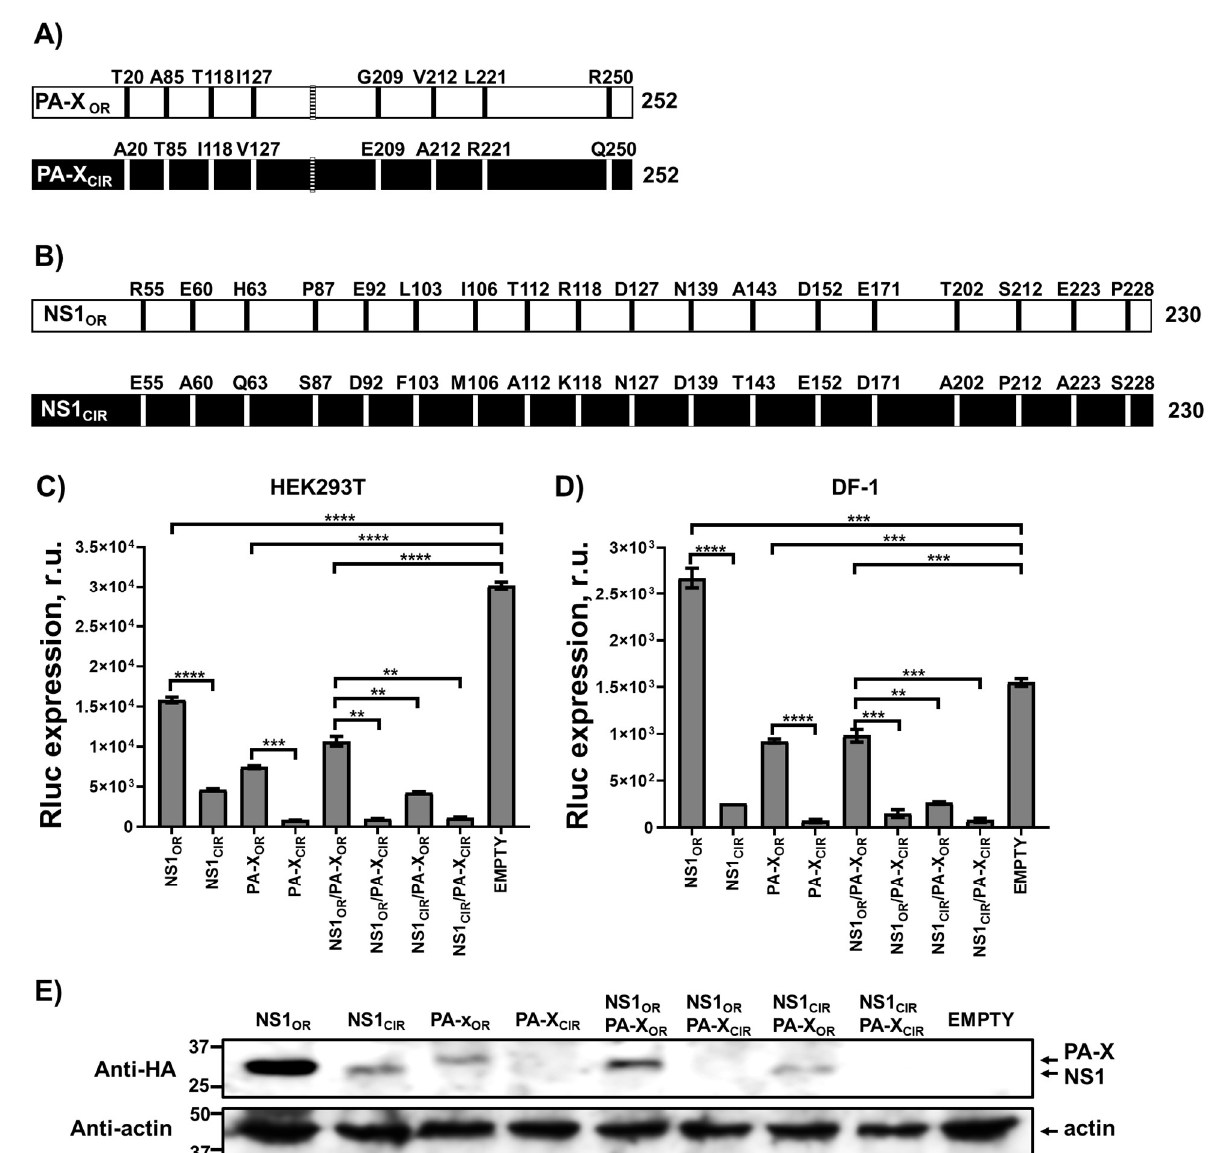
Figure 1. Effect of H5N1 NS1 and PA-X amino acid changes on host gene expression. ( A , B ) Schematic representation of PA-X ( A ) and NS1 ( B ) amino acid residues most frequently present in H5N1 IAV circulating in avian and humans during 1996–1997 (OR, original), and from viruses circulating since 2016 (CIR, circulating). The PA-X +1 frameshift motif (UCC UUU CGU C) is indicated with a striped bar ( A ). ( C–E ) Human HEK293T ( C , E ) and avian DF-1 ( D ) cells were transiently co-transfected with a pCAGGS empty plasmid, or with pCAGGS plasmids expressing the indicated HA epitope-tagged NS1 and PA-X viral proteins, together with a Rluc expressing pCAGGS plasmid. NS1 CIR protein encodes the amino acid changes R55E, E60A, H63Q, P87S, E92D, L103F, I106M, T112A, R118K, D127N, N139D, A143T, D152E, E171D, T202A, S212P, E223A, and P228S; whereas the PA-X CIR protein encodes the amino acid changes T20A, A85T, T118I, I127V, G209E, V212A, L221R, and R250Q. At 24 h p.t, Rluc expression ( C and D ) was quantified using a luminometer. Error bars represent the standard deviations from triplicates. *, p < 0.05; **, p < 0.005; ***, p < 0.0005; ****, p < 0.0001 (NS1 OR versus NS1 CIR , PA-X OR versus PA-X CIR , NS1 OR /PA-X OR versus NS1 OR /PA-X CIR , NS1 OR /PA-X OR versus and NS1 CIR /PA-X OR and NS1 OR /PA-X OR versus NS1 CIR /PA-X CIR ) using a Student’s t -test. R.u., relative units. NS1, PA-X, and actin protein expression levels in HEK293T transfected cells were analyzed by Western blot using cells extracts and antibodies specific for the HA tag, to detect NS1 and PA-X proteins (bottom and top bands in the upper blot, respectively); and actin (bottom blot) ( E ). Molecular mass markers (in kDa) are indicated on the left. The experiments were repeated three times, with similar